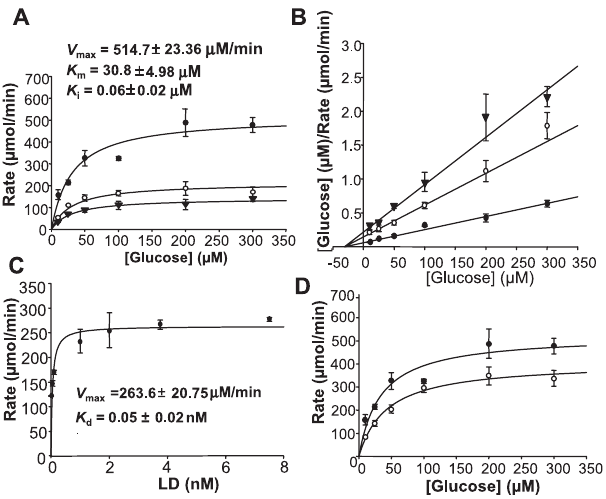
Figure 2. Effect of Cox11 and RanBP2 on HKI Activity (A) Saturation kinetics, rate versus glucose of HKI (0.24 l g) in the absence (solid circles) and presence of Cox11 (open circles, 0.25 nM; solid triangles, 7.5 nM). The activity of HKI decreases with increasing concentrations of Cox11. No measurable HKI activity was recorded in the presence of 15 nM of Cox11 (unpublished data). (B) Hanes-Wolf plot of (A) (1/rate versus glucose) in the absence and presence of fixed concentrations of Cox11. Linearity of reciprocal plots also supported the hyperbolic behavior of the reactions (unpublished data). Cox11 behaves as a noncompetitive inhibitor of HKI by reducing the V max of HKI but not its K m toward glucose. (C) HKI rate is plotted as a function of LD concentration at saturating glucose and fixed Cox11 (7.5 nM) concentrations. Note that increasing concentrations of the LD of RanBP2 reverse the inhibition of HKI activity by Cox11. A half-maximal effect of the LD of RanBP2 on HKI activity in the presence of 7.5 nM of Cox11 was observed at a concentration of ; 0.05 nM of LD. (D) Rate versus glucose plot in the absence and presence of the LD of RanBP2. At a saturating concentration of the LD of RanBP2 (3.75 nM), the HKI activity was reduced by about 20%. v, rate; S, glucose. DOI: 10.1371/journal.pgen.0020177.g002 PLoS Genetics |